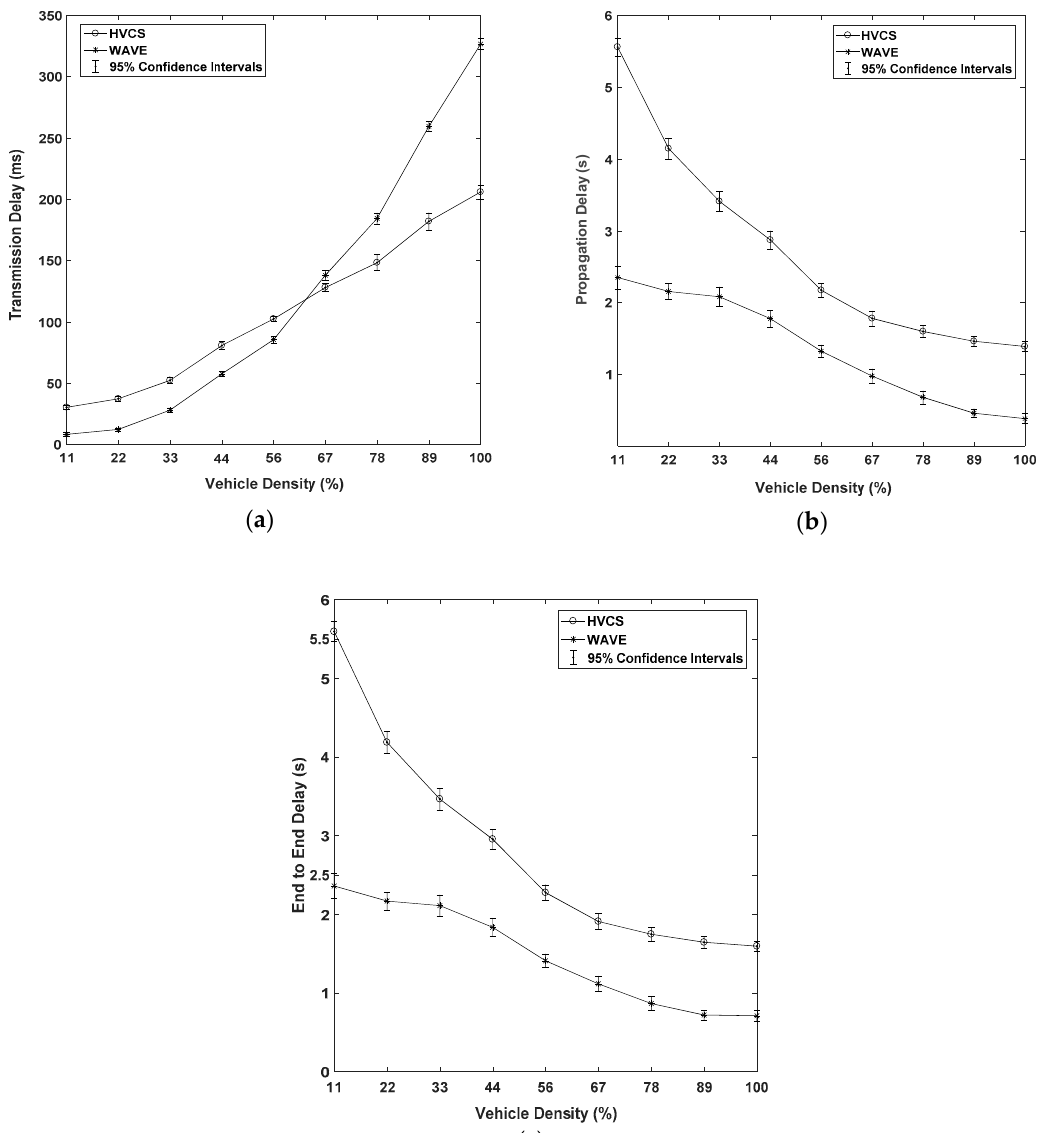
Figure 11. System connection performance (the vehicle density was rounded o ff to the nearest whole number): ( a ) Transmission delay; ( b ) Propagation delay; ( c ) End-to-end